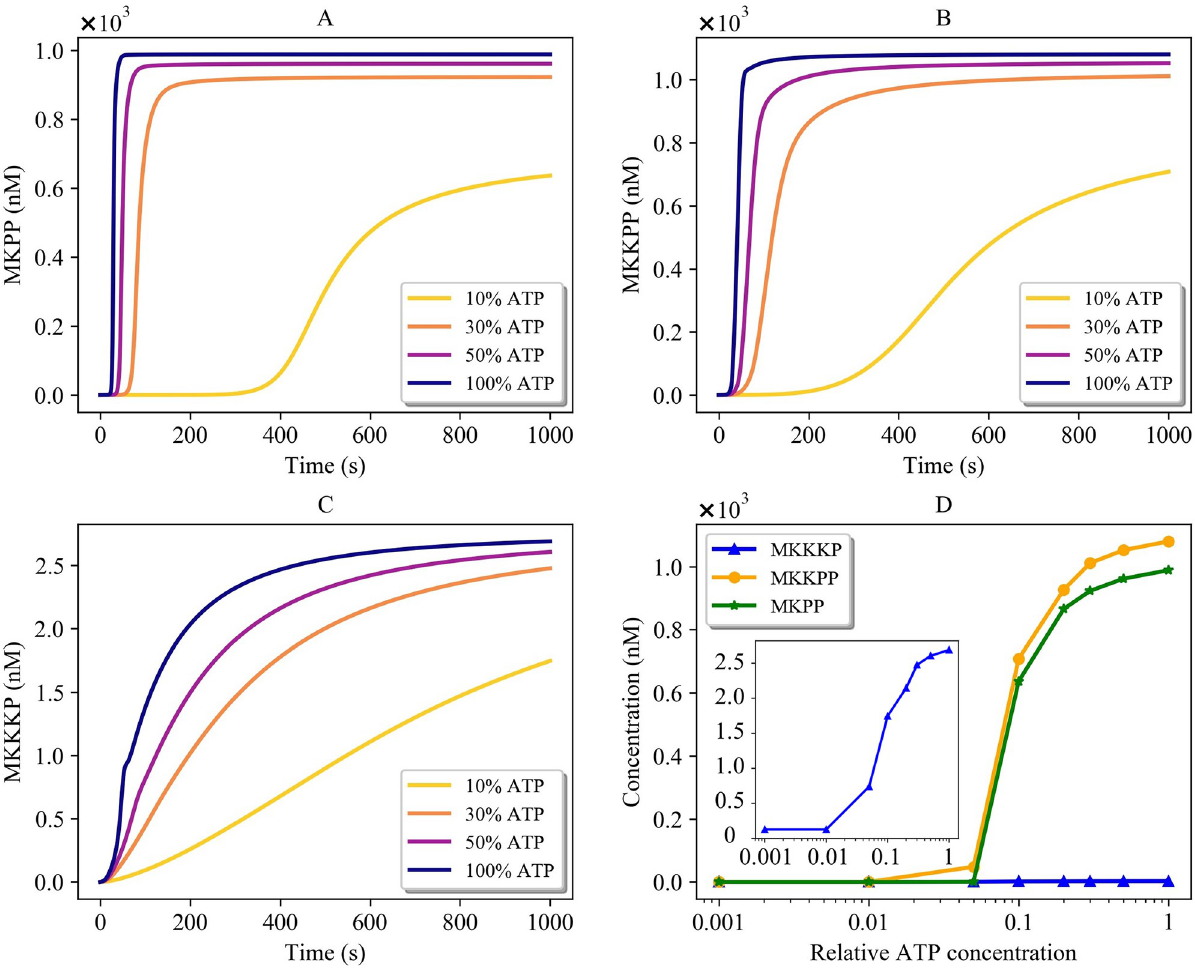
Fig 17. Effect of different levels of ATP concentration on activated kinases in the composed EGFR-Ras-MAPK bond graph model. (A) MKPP; (B) MKKPP; (C) MKKKP; (D) Steady-state concentration of MKKKP, MKKPP, and MKPP against relative ATP concentration. MKKKP concentration is also separately shown in a box due to its relatively small amounts compared to MKKPP and MKPP (initial concentration of common species: Ras = 0, RShGS =